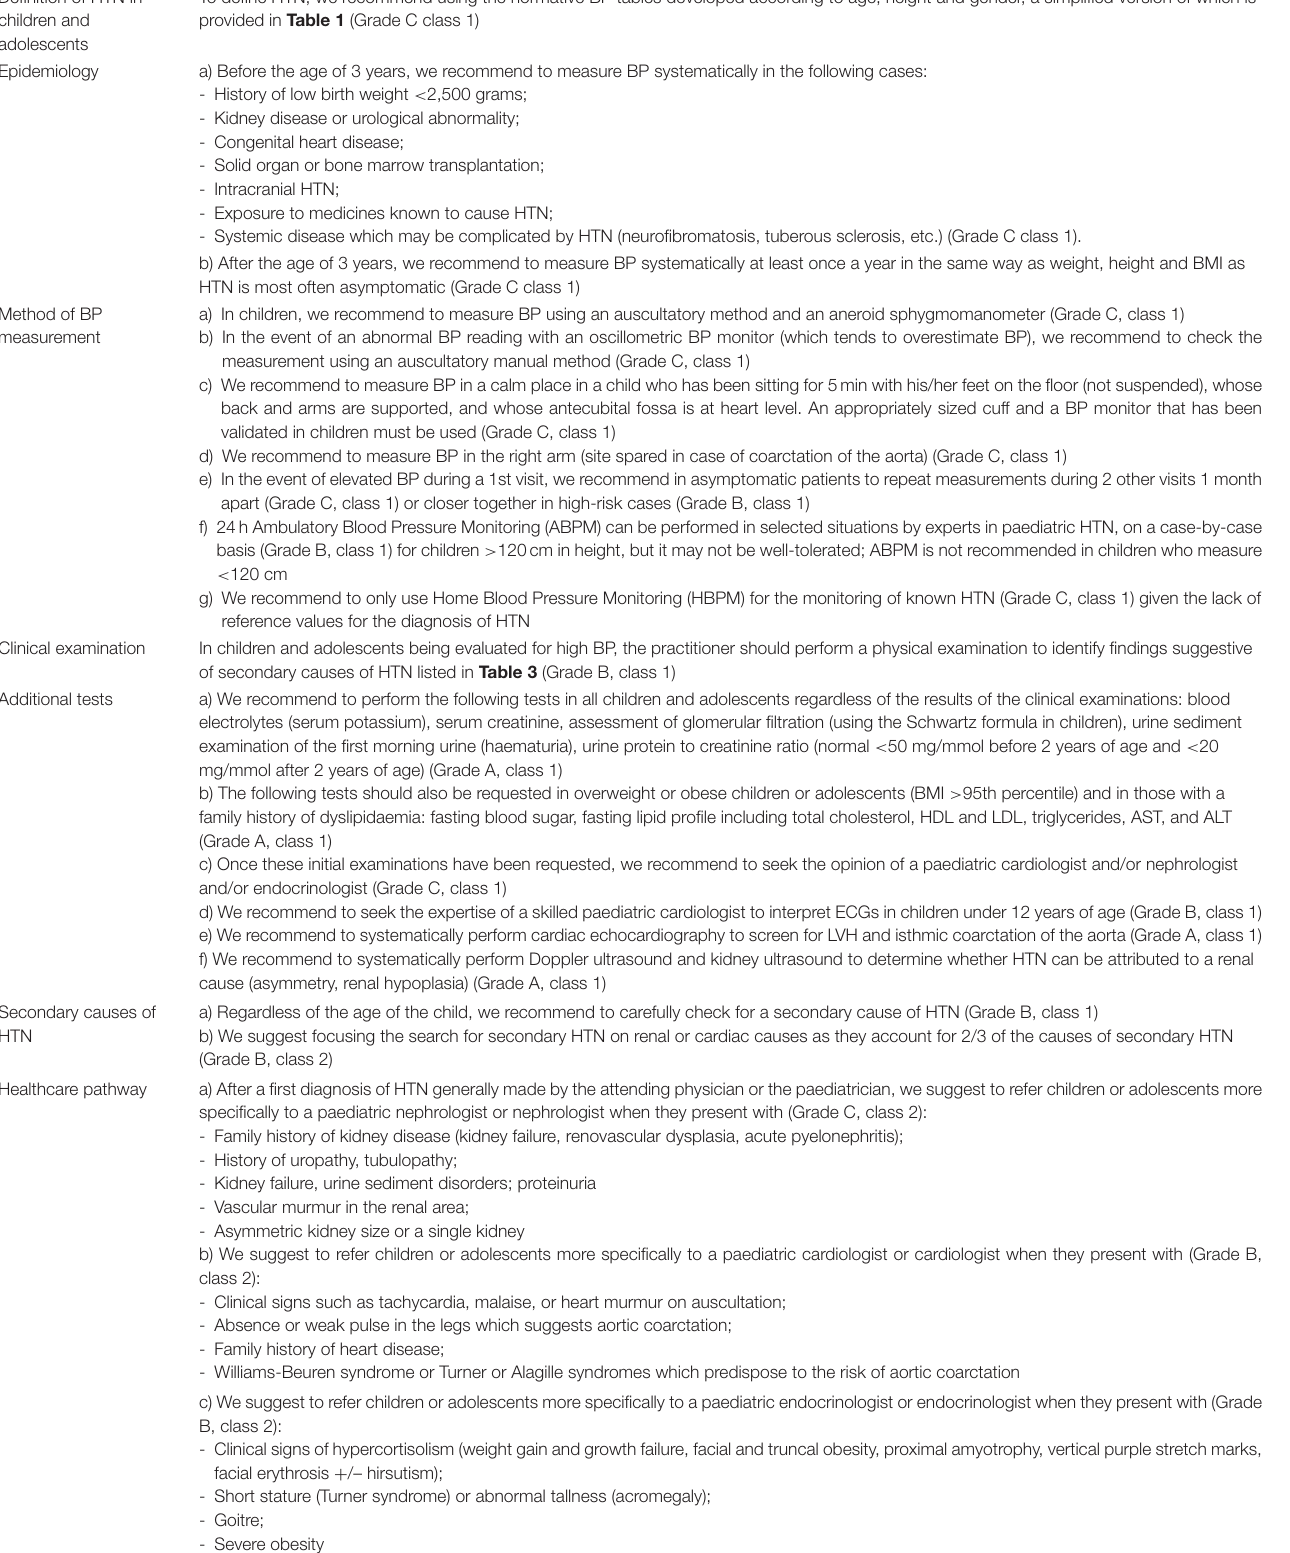
TABLE 7 | Summary of the